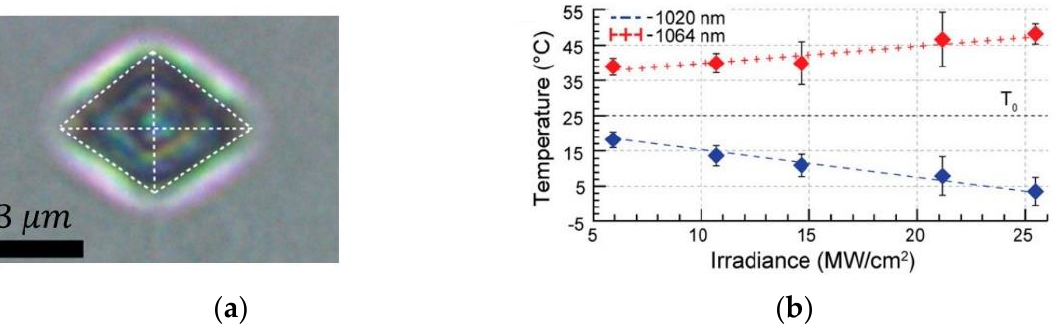
Figure 9. Temperature of individually trapped β -NaYF 4 nanowires under 1020 nm laser irradiance: ( a ) undoped samples (0% Yb 3+ :NaYF 4 ) and ( b ) 10% Yb 3+ :NaYF 4 samples. In [38], a similar approach based on single-beam laser trapping at the wavelength 1020 nm was used for optical refrigeration of Yb 3+ :YLF nanocrystals (Figure 10a) prepared